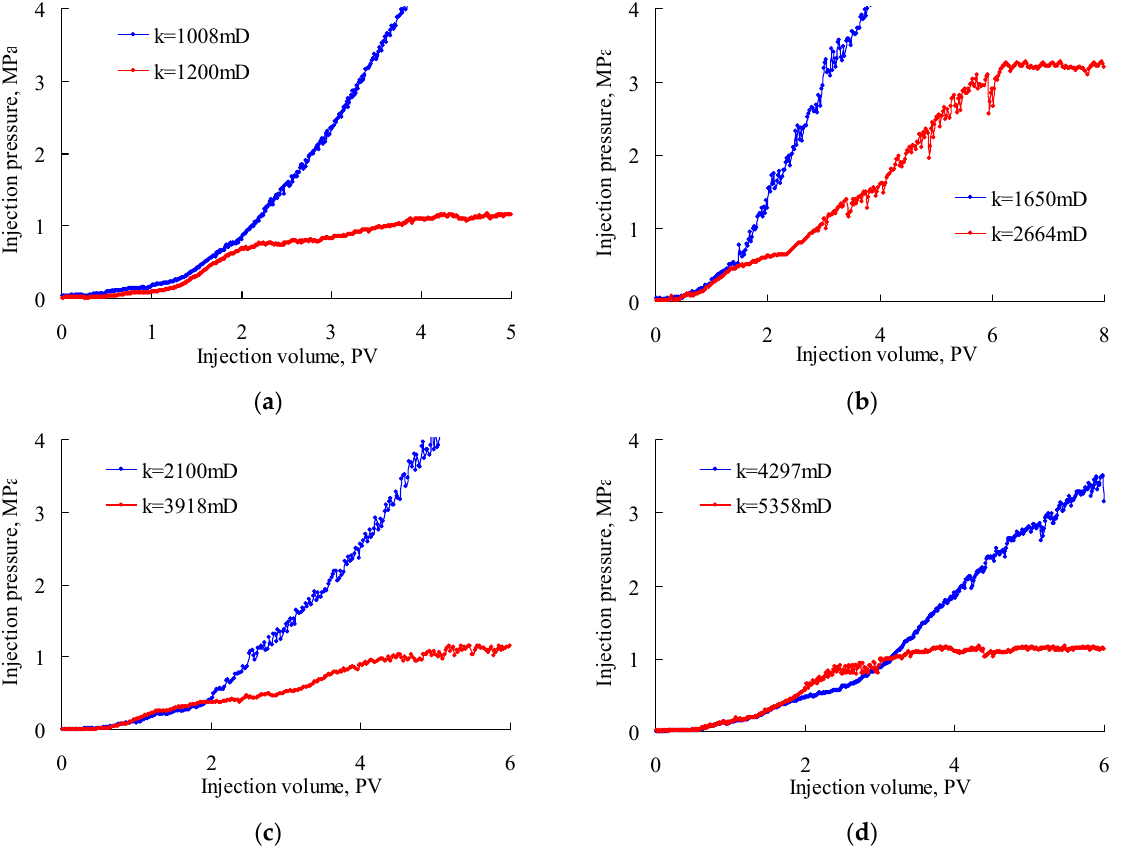
Figure 5. Injection pressure versus injection volume of PPGs (12–16 Pa) with different powder sizes: ( a ) 120–150 mesh, ( b ) 100–120 mesh, ( c ) 80–100 mesh and ( d ) 60–80 mesh.